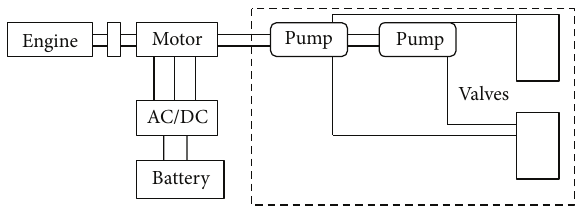
Figure 1: A schematic of a parallel hybrid hydraulic excavator.